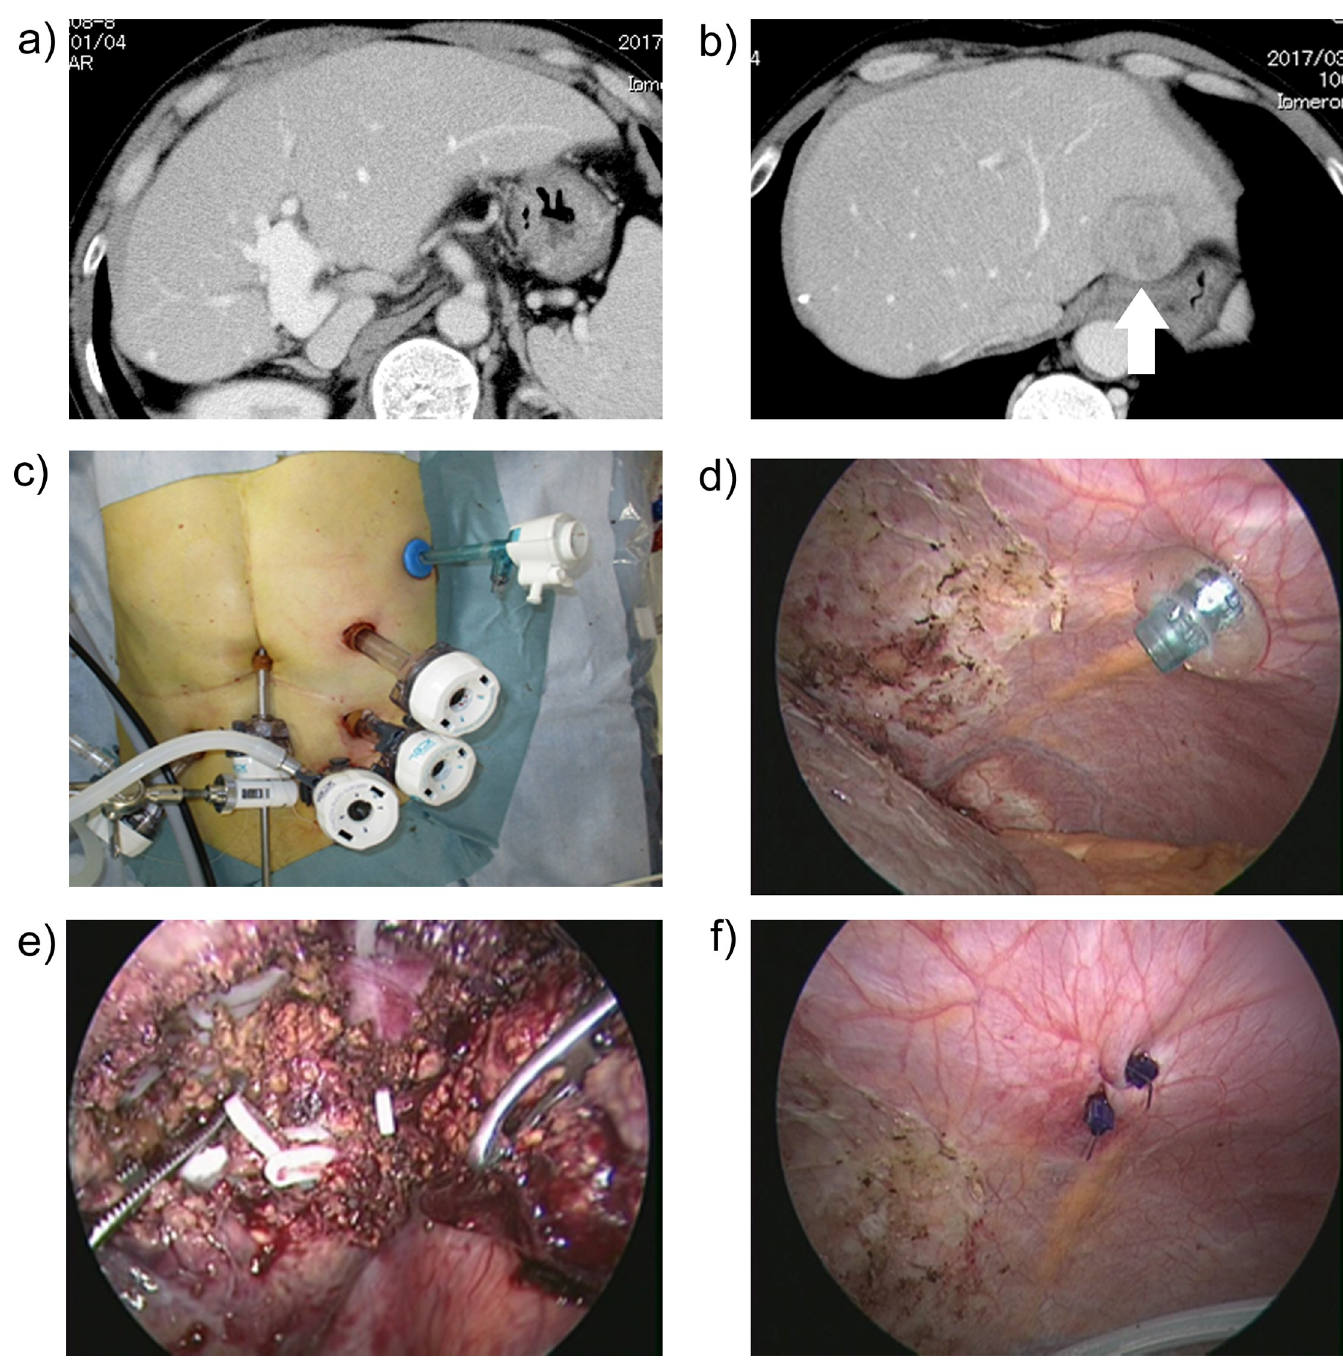
Fig 2. Application of a left intercostal diaphragmatic port in repeated hepatectomy. a), b) Enhanced computed tomography shows a recurrent hepatocellular carcinoma located in segment II after open right hemi-hepatectomy. An arrow indicates the recurrent tumor. c) Extracorporeal view of the left intercostal port.d) Intracorporeal view of the left intercostal port.e) View during repeated hepatectomy. f) Suture of the port hole. https://doi.org/10.1371/journal.pone.0234919.g002 especially in a repeated hepatectomy. When the conventional approach has the difficulty in adjusting the axis of the forcep or CUSA to adequate towing direction or transection line because of the adhesion, the intercostal trans-diaphragmatic port was chosen. In all 32